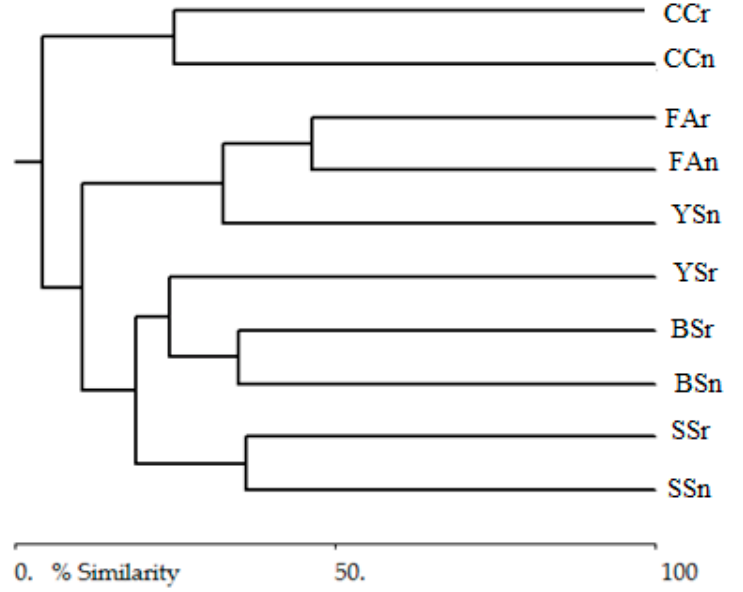
Figure 2. Cluster analysis based on the Jaccard index and UPGMA representing the faunistic rela- tionships between the rivers sampled from the Sierra de Juárez, Oaxaca, Mexico.